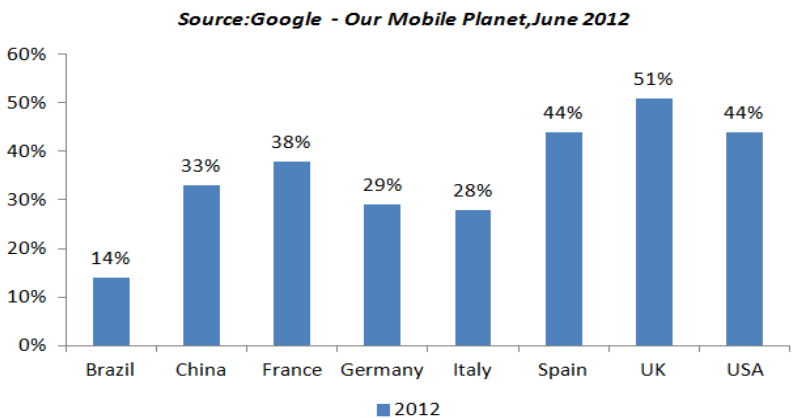
Figure 1. Country wise penetration of Smartphones